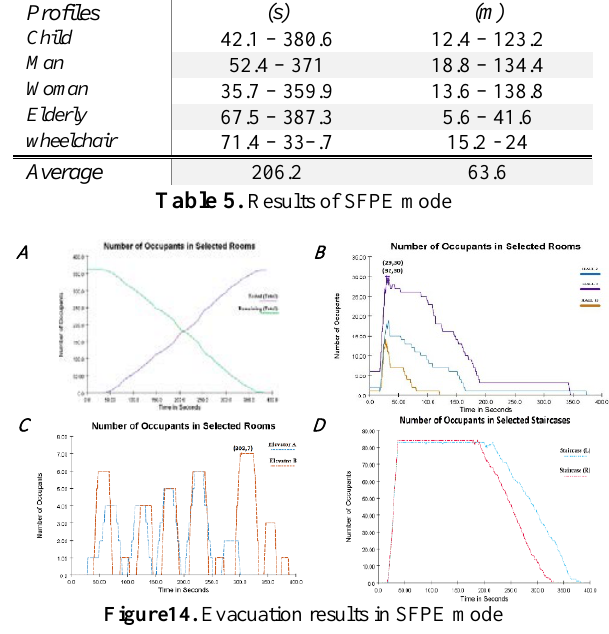
Figure14. Evacuation results in SFPE